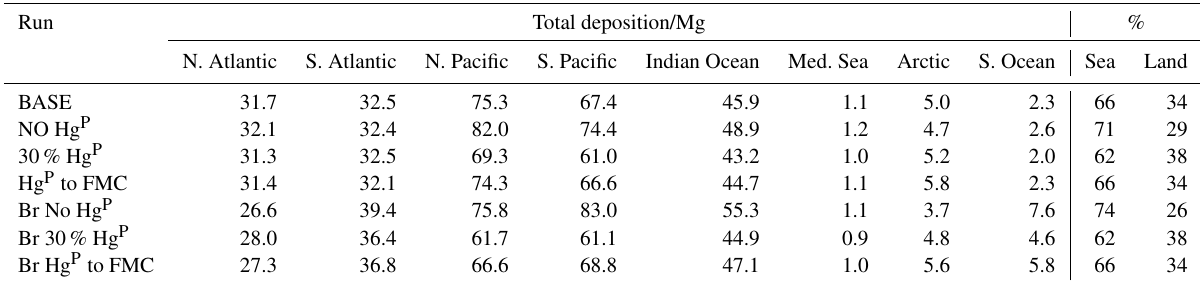
Table 4. Hg deposition (Mg) coming from BB to the oceans as obtained by the different runs for the 2013. The last two columns reports the percentage of the total Hg that deposits over sea and land. Run